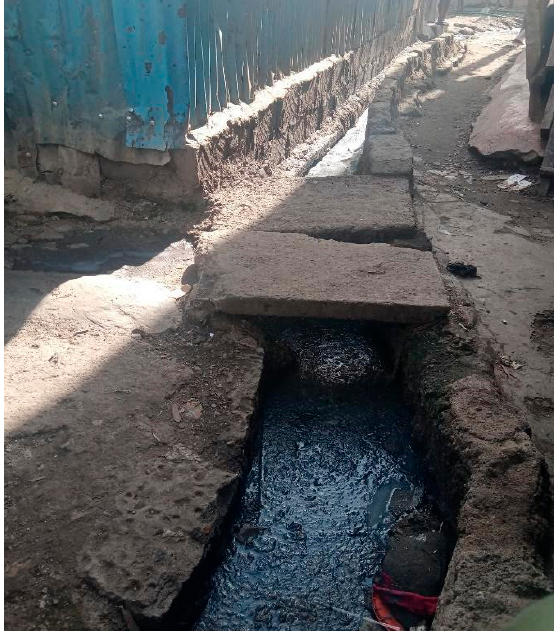
Figure 2. “They should build for us a proper sewage system…the ones constructed underground so that we cannot see them. It also prevents us from contracting many diseases” (Daniel, 17-year-old boy, Viwandani).